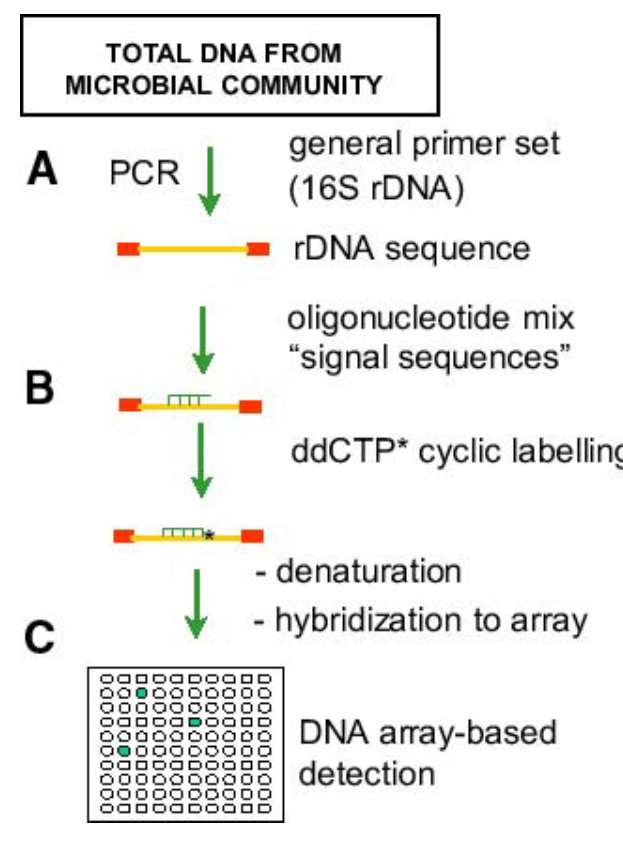
FIGURE 1. Schematic representation of the DNA array method. Total DNA from a microbial community is PCR amplified with universal 16S rDNA primers (A). Then, specific probes are added and labeled sequence specifically (B). Finally, the probes are hybridized to their respective complements on a solid phase